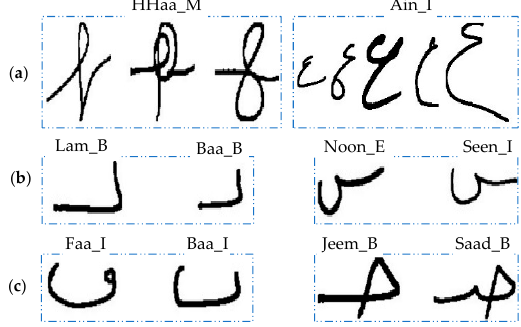
Figure 1. Illustration of some challenges of Arabic characters. ( a ) An isolated Ain has a different size and shape depending on the writer’s style. Additionally, the Middle HHAA is written in three different shapes; ( b ) End Noon and isolated Seen have very similar shapes; ( c ) Beginning Saad has a small stroke differentiating it from Beginning Jeem; isolated Faa with a small number of points as a loop distinguishes it from isolated